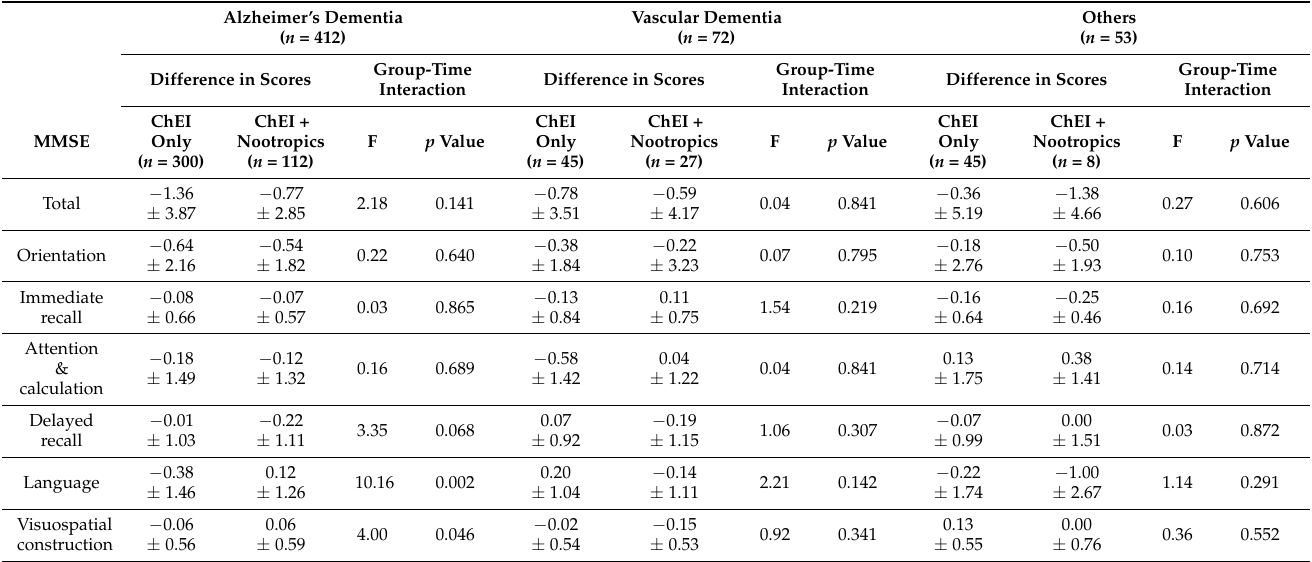
Table 4. Results of mixed model analyses 1 for mini-mental state examination (MMSE) for highly- adherent 2 Alzheimer’s Dementia